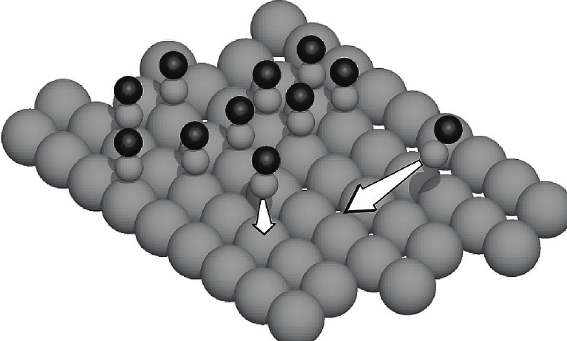
Figure 2. Adsorption of 14 C compounds on the surface of irradi- ated nuclear